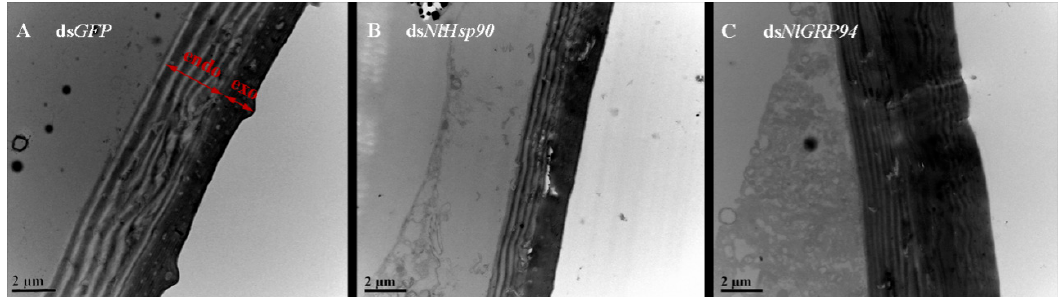
Figure 9. Transmission electron microscopy observation of the dorsal abdominal integument of the sixth-day females in ( A ) the ds GFP -injected group, ( B ) the ds NlHsp90 -injected group and ( C ) the ds NlGRP94 -injected group.